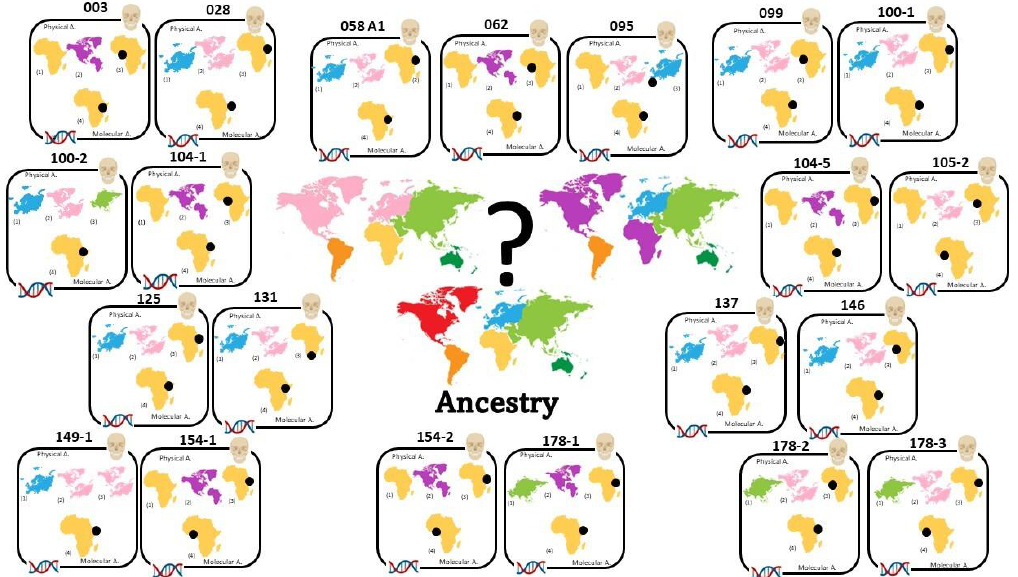
Figure 5. Physical and molecular ancestry estimation results: ( 1 ) HefnerR: African, European, Asian, Native American [24]; ( 2 ) OSSA score: Black (Afro-American), White (Euro-American) [23]; ( 3 ) Cra- niometrics: Somali, Zulu, West Africa, Portuguese; Euro-American; Hainan (Asia); ( 4 ) SmartPCA [38]. , African; , West African; , Zulu; , Somali; , Portuguese; , Euro-American; , Hainan (Asia); , Afro-American.